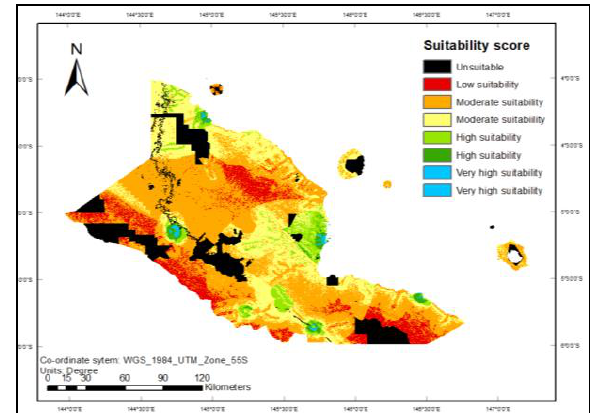
Figure 11. AHP weights of land-use suitability assessment for